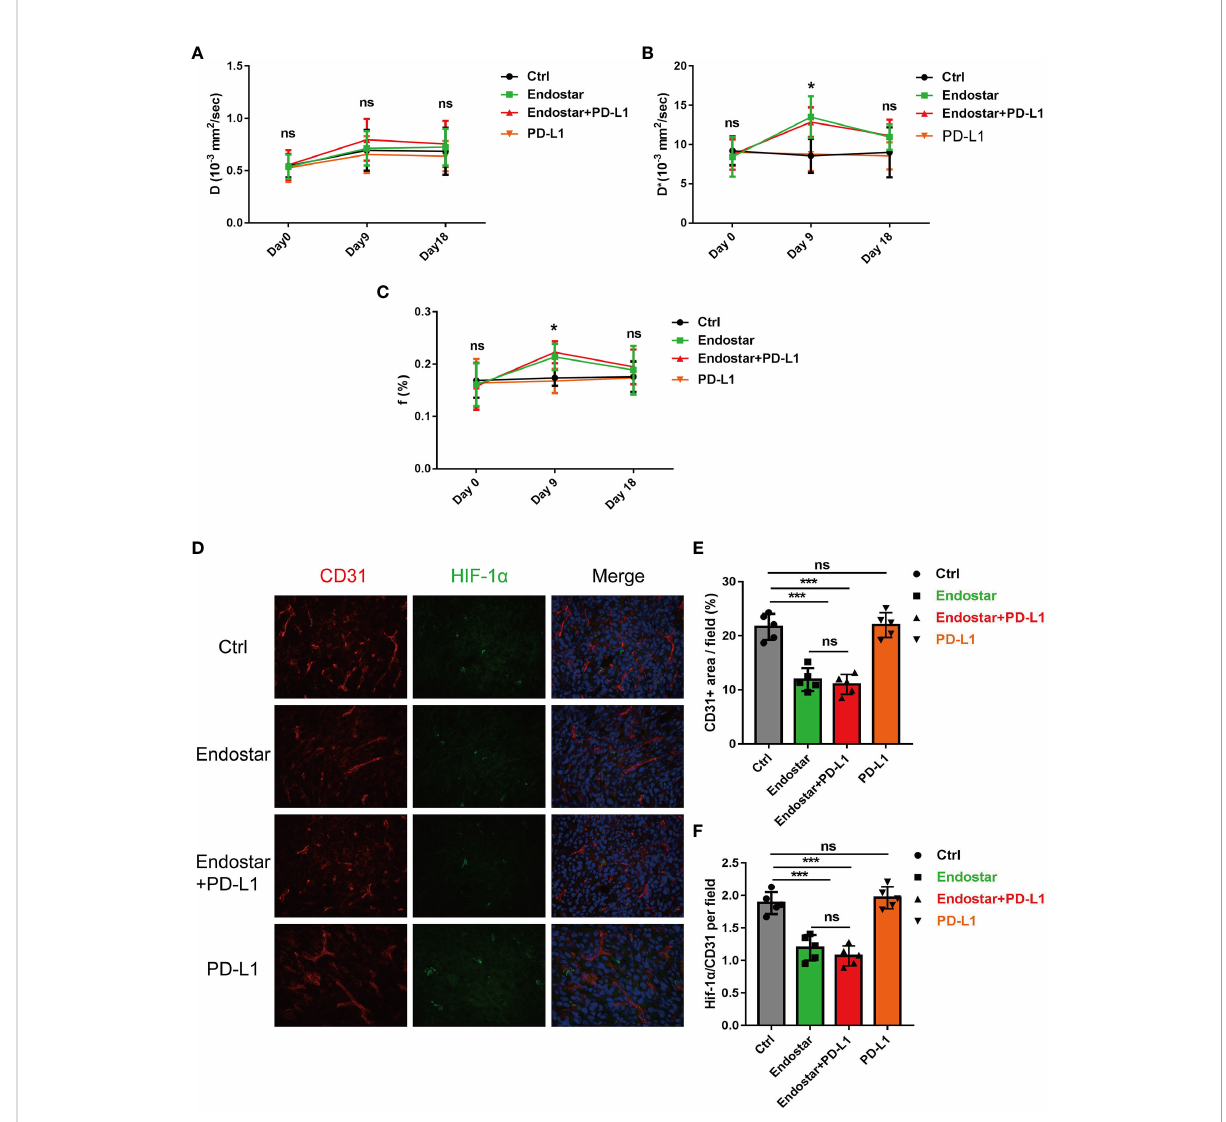
FIGURE 2 Changes of intravoxel incoherent motion diffusion-weighted magnetic resonance imaging (IVIM-DWI MRI)-related indexes in Endostar, Endostar+programmed death ligand-1 (PD-L1), and PD-L1 groups after intervention of colorectal cancer (CRC) mouse tumor. (A) Comparison of real diffusion coef fi cients (D) of water molecules in the four groups of mouse tumors at different times. (B) Comparison of pseudo diffusion coef fi cients (D*) of four groups of mouse tumors at different times. (C) The microvascular volume fraction (F) of water molecules in the tumor of mice in group was compared at different times. (D – F) Comparison of microvessel density and tissue hypoxia parameters of CRC by different interventions (*P< 0.05, ***P< 0.001). ns, not signi fi cant,